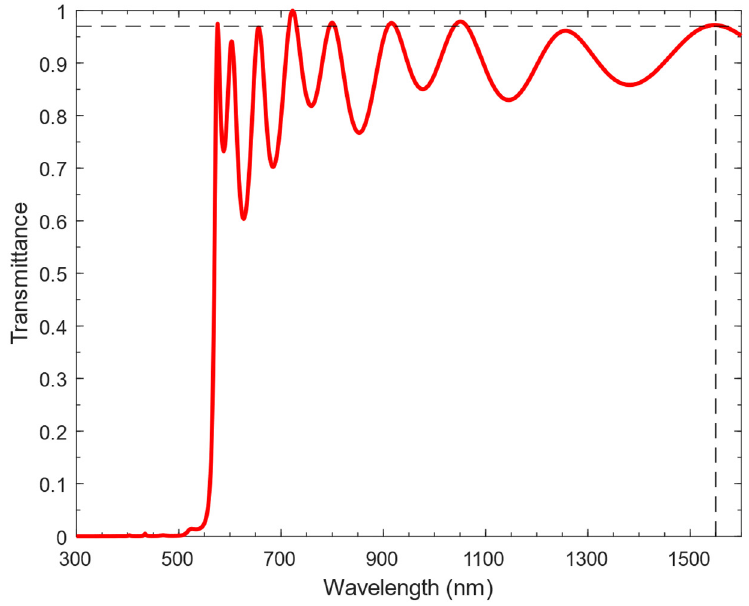
Figure 8. Transmission spectrum of the designed distributed Bragg